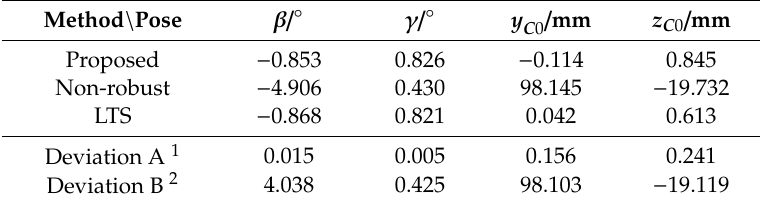
Table 3. Pose parameter acquired by the proposed method and non-robust method.